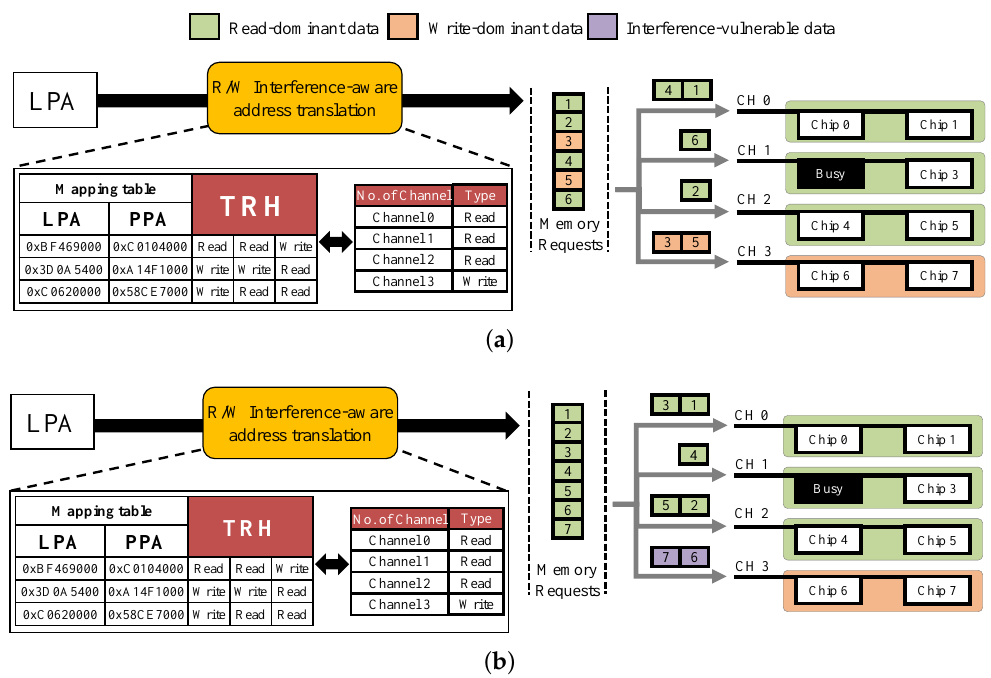
Figure 4. R/W-interference-aware page allocation: ( a ) basic allocation flow; ( b ) allocation flow with strongly imbalanced